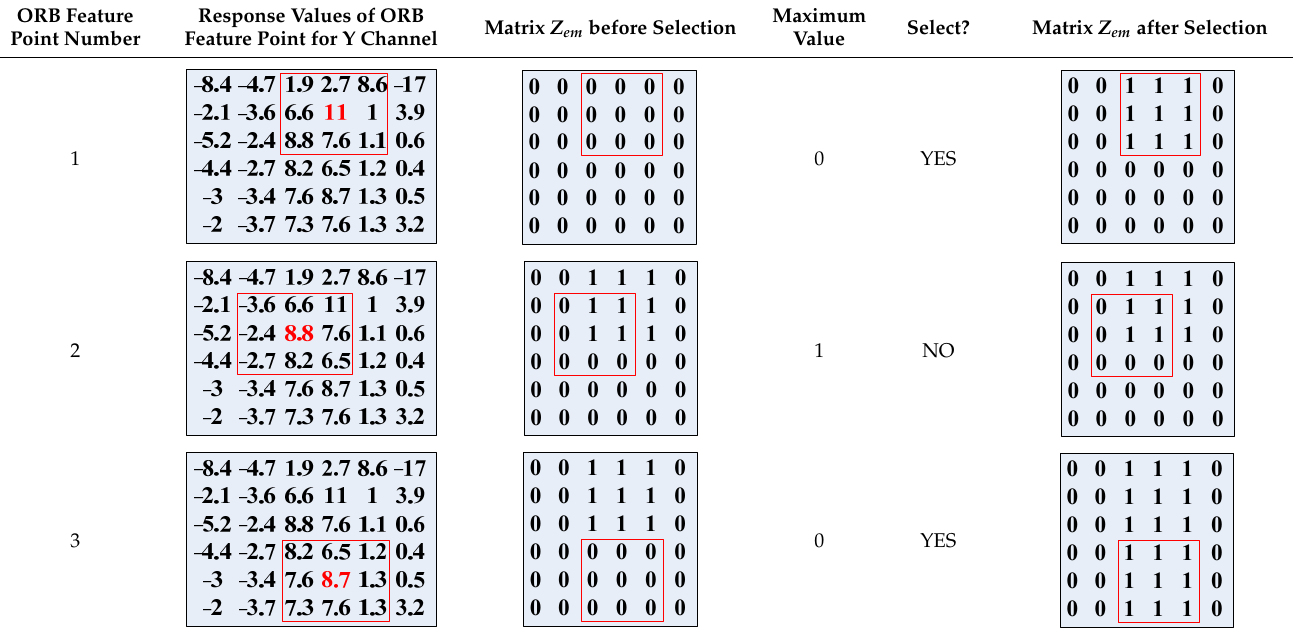
Table 1. Applying the Hamming window to filter out non-overlapping feature regions.